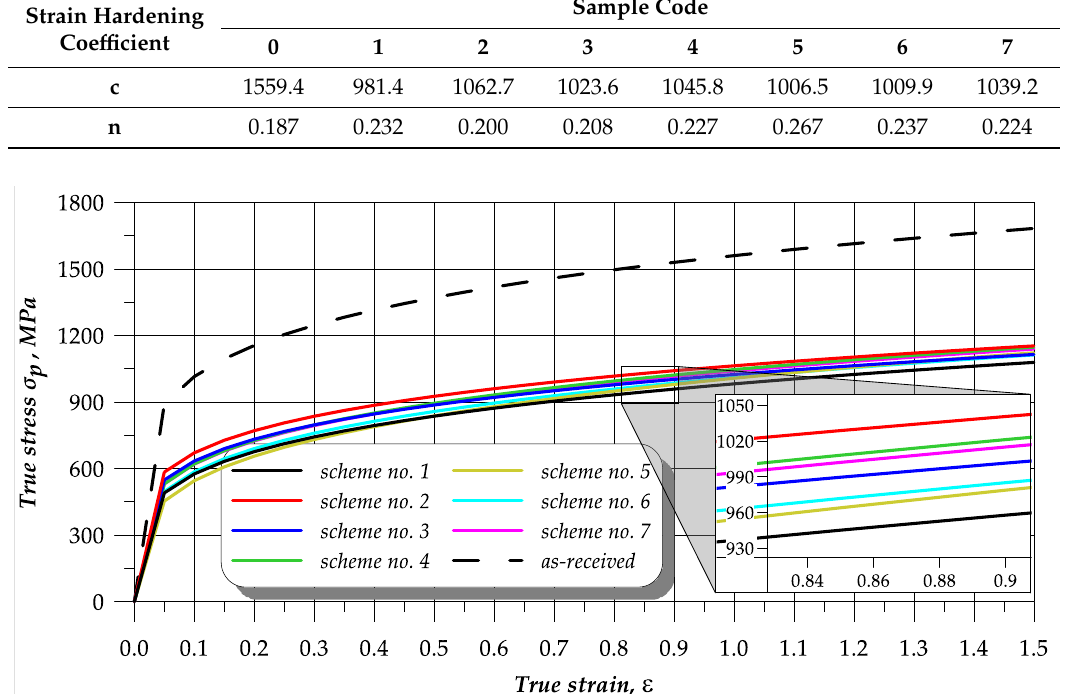
Figure 11. Effect of hardness on strain-hardening coefficients. 3.4. Comparison of the Numerical and Experimental Upsetting Results The determined flow curves were used in the numerical simulation of the upsetting of cylindrical samples, with the simulation conditions reflecting the experimental ones. The quality of the numerical results was assessed based on the force parameters. Figure 12 shows the force during the upsetting of samples that were annealed according to scheme no. 3, which is, as already mentioned, an intermediate scheme between extreme schemes no. 1 and 2. The experimental and